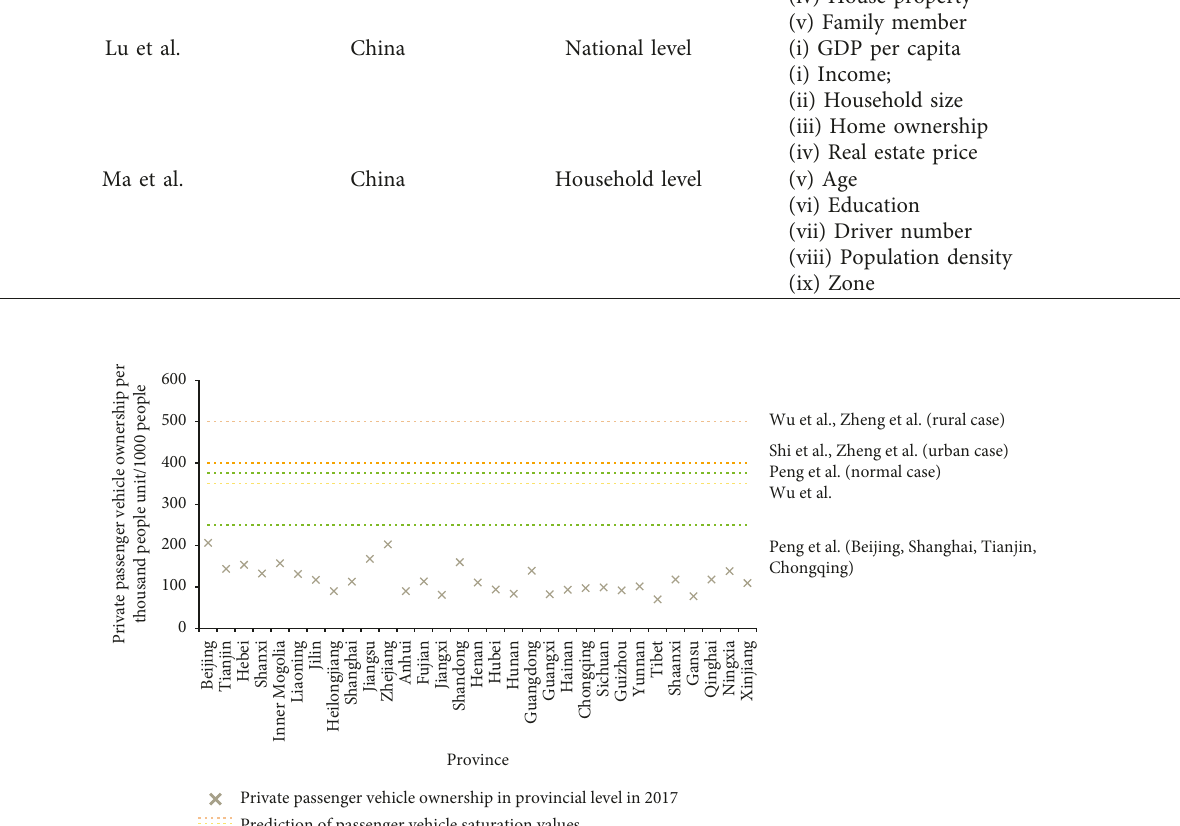
Figure 1: Private passenger vehicle ownership per thousand people in provincial level in China and some predictions of passenger vehicle saturation values in